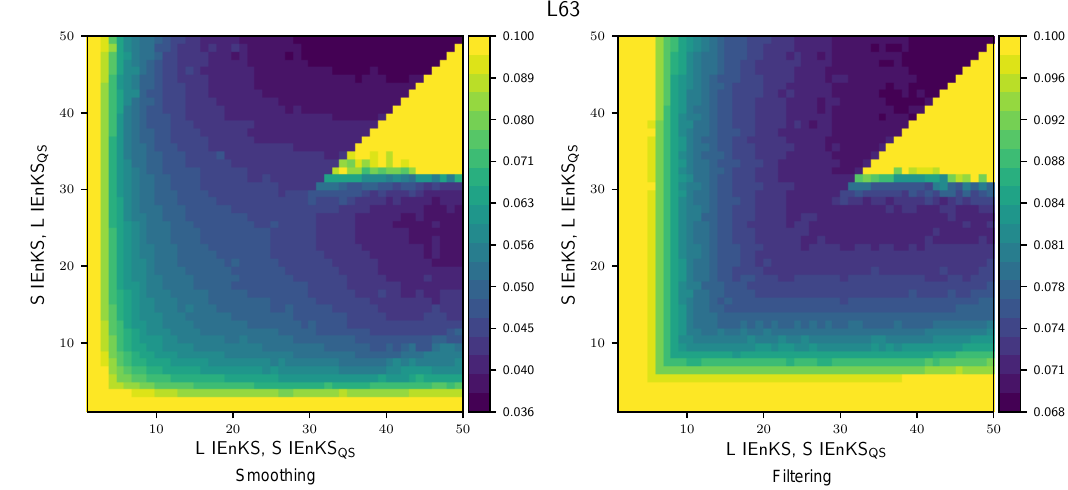
Figure 9. IEnKS (lower triangles) and IEnKS QS (upper triangles, N Q = S ) smoothing and filtering aRMSEs as a function of L and S with the L63 model. The L parameter is on the abscissa axis for the IEnKS and on the ordinate axis for the IEnKS QS . The S parameter is on the abscissa axis for the IEnKS QS and on the ordinate axis for the IEnKS. For readability, smoothing and filtering RMSE beyond 0.10 are in the same color and the scale is